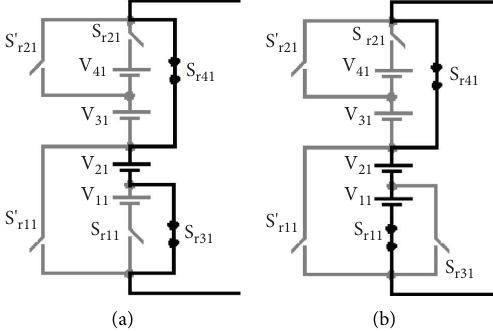
Figure 4: Operating mode: (a) V